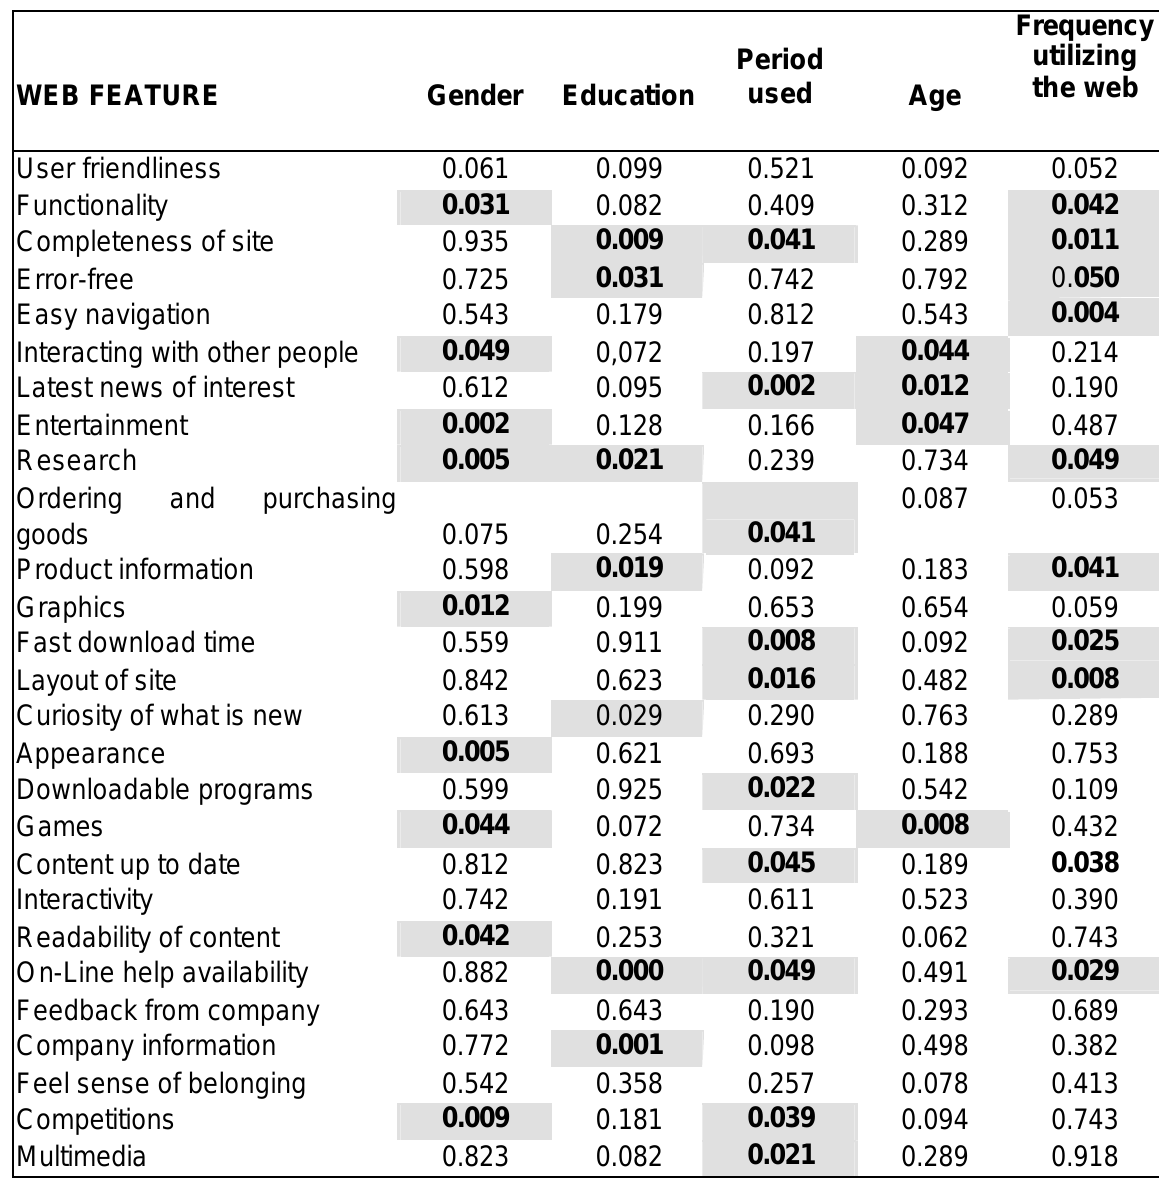
TABLE 6: SUMMARY OF ANALYSIS OF VARIANCE BETWEEN THE IMPORTANCE OF FEATURES AND THE PROFILE OF